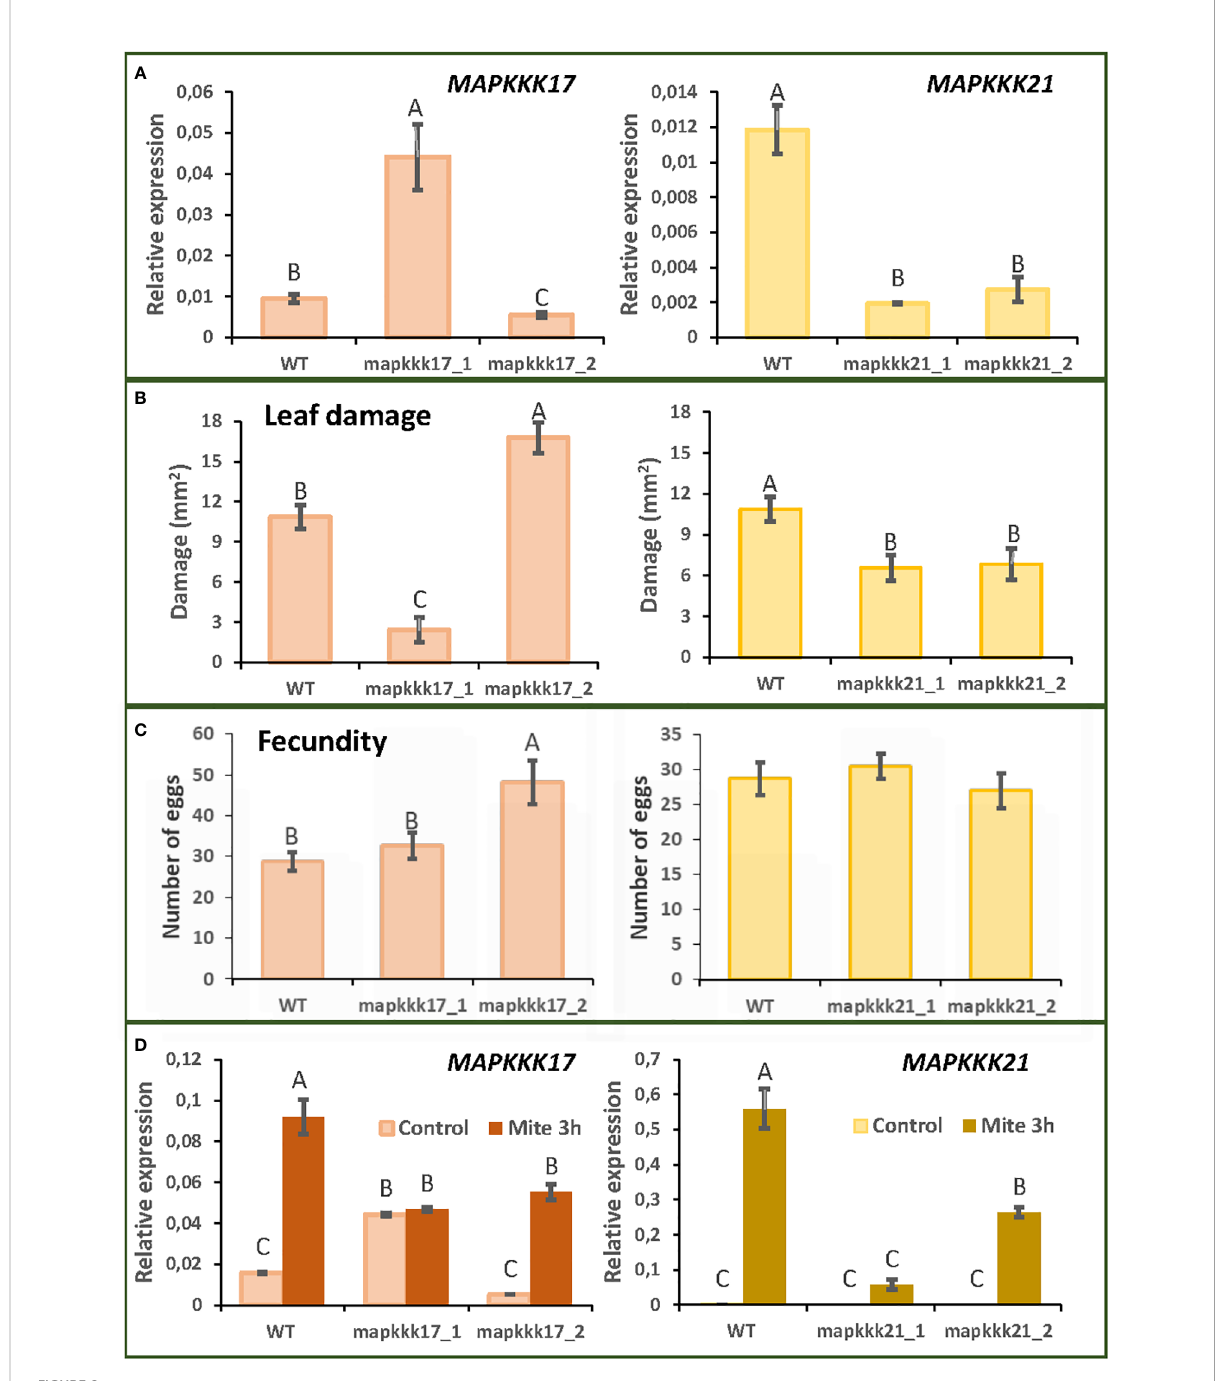
FIGURE 2 Plant damage and mite performance after feeding on Arabidopsis WT and T-DNA insertion lines for MAPKKK17 and MAPKKK21 . (A) Relative expression levels of MAPKKK17 and MAPKKK21 in WT and T-DNA inserted lines. Data are means ± SE of three biological replicates. (B) Foliar damaged area quanti fi ed after 4 d of mite infestation. Data are mean ± SE of eight replicates. (C) Effects on T. urticae fecundity quanti fi ed as the number of eggs 36 h after infestation with synchronized mite females. Data are mean ± SE of eight replicates. (D) Relative expression levels of MAPKKK17 and MAPKKK21 in WT and T-DNA inserted lines after 3h of mite infestation. Data are means ± SE of three biological replicates. Different letters indicate signi fi cant differences (P<0.05, One-way ANOVA followed by Student-Newman-Keuls multiple comparisons